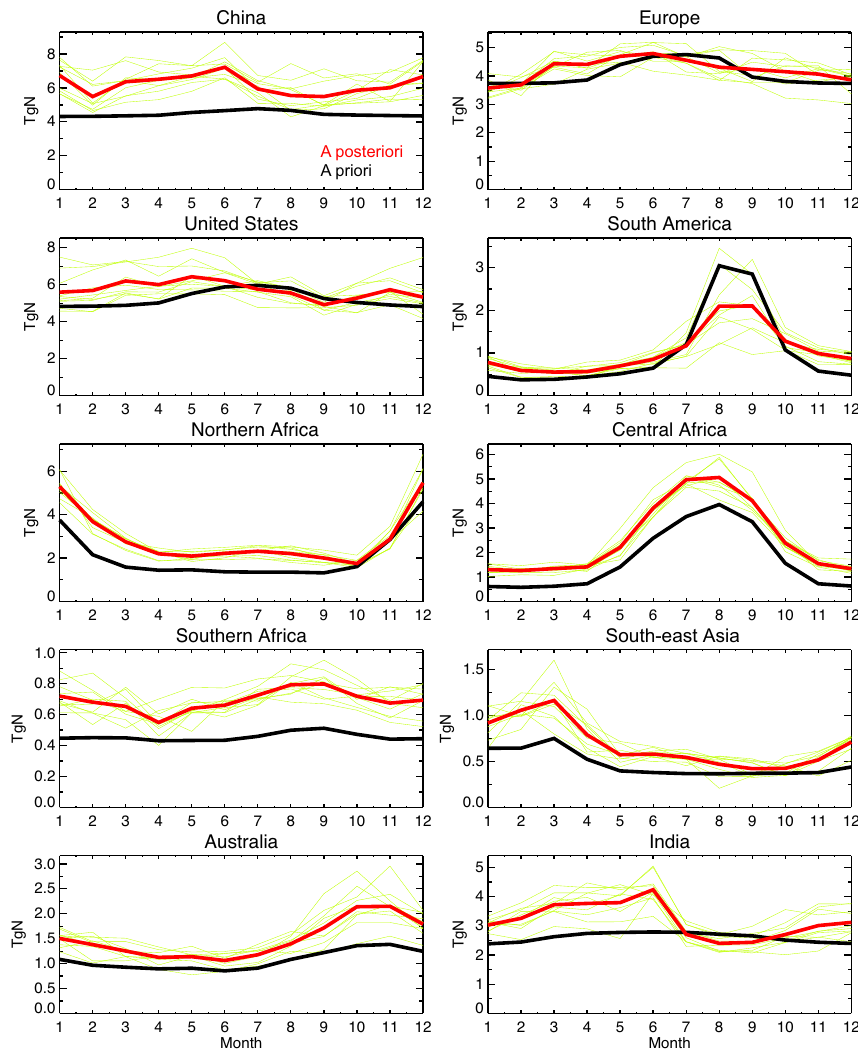
Figure 8. Seasonal variations of the regional surface NO x emissions (in TgNyr − 1 ) obtained from the a priori emissions (black line) and the a posteriori emissions (red line) averaged over the period 2005–2014. The results are also shown for the a posteriori emissions for individual years during 2005–2014 (yellow